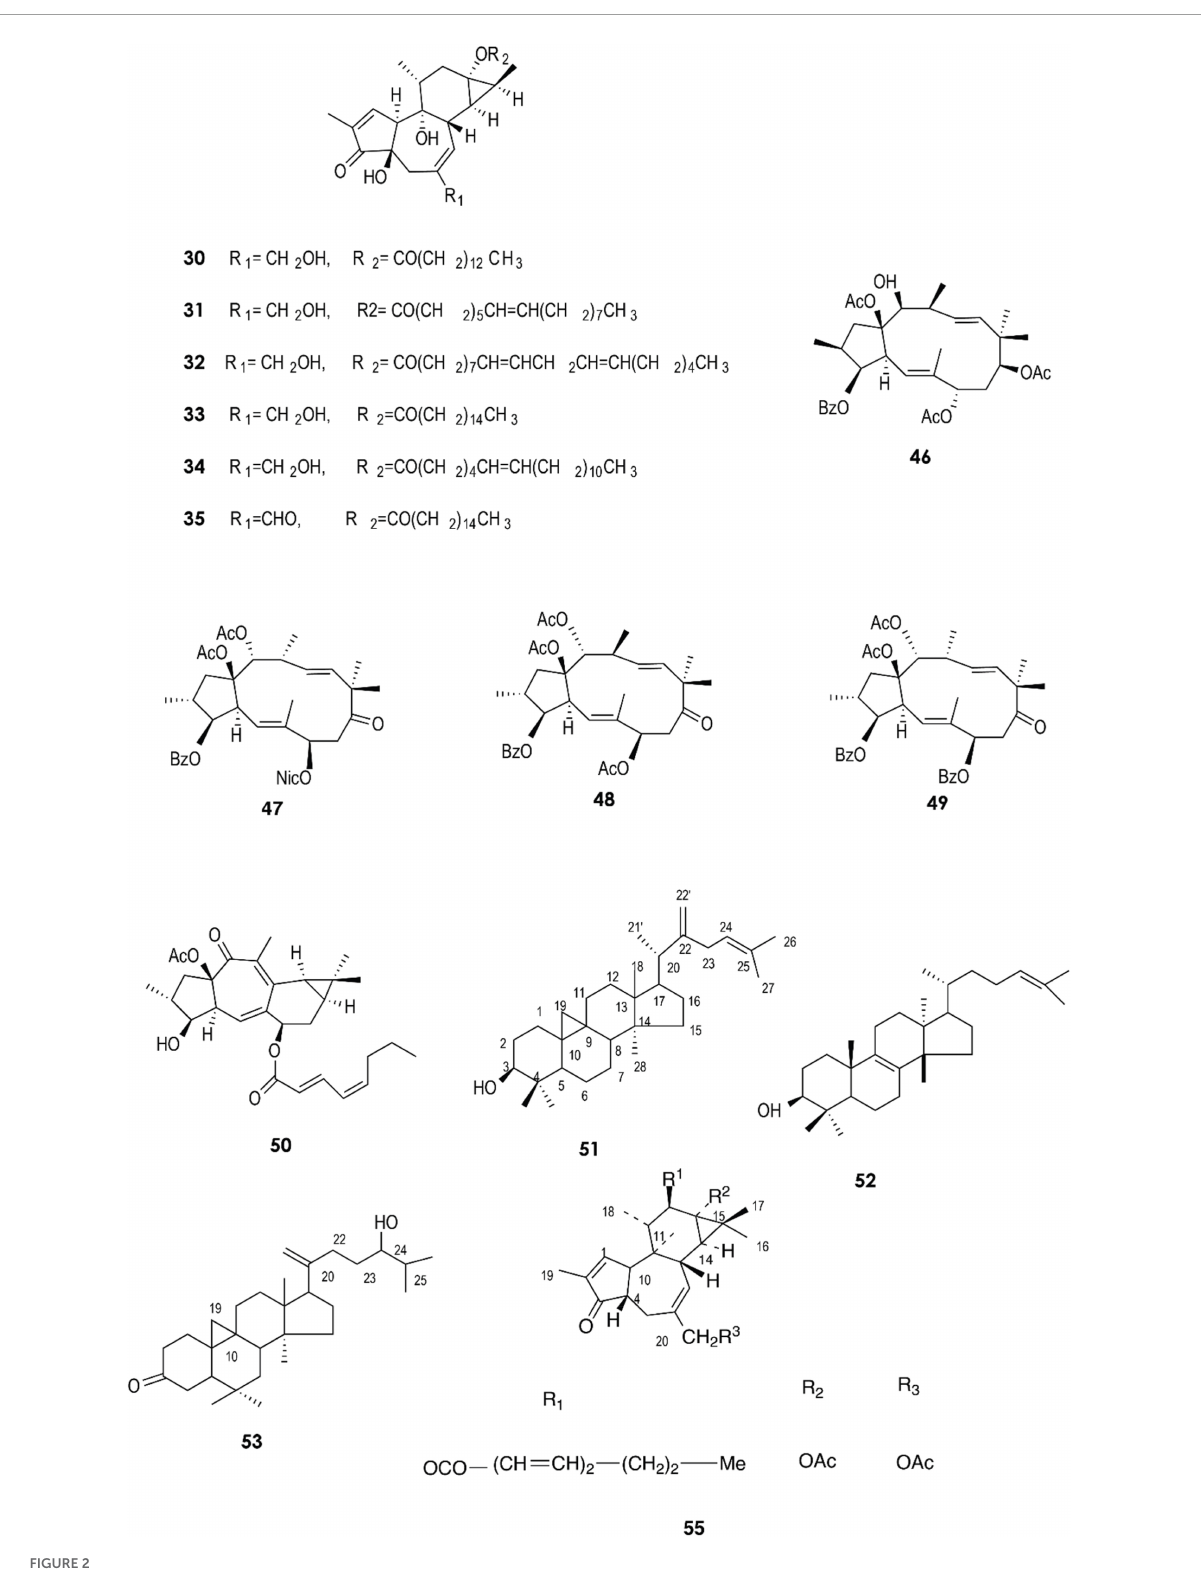
Frontiers in Plant